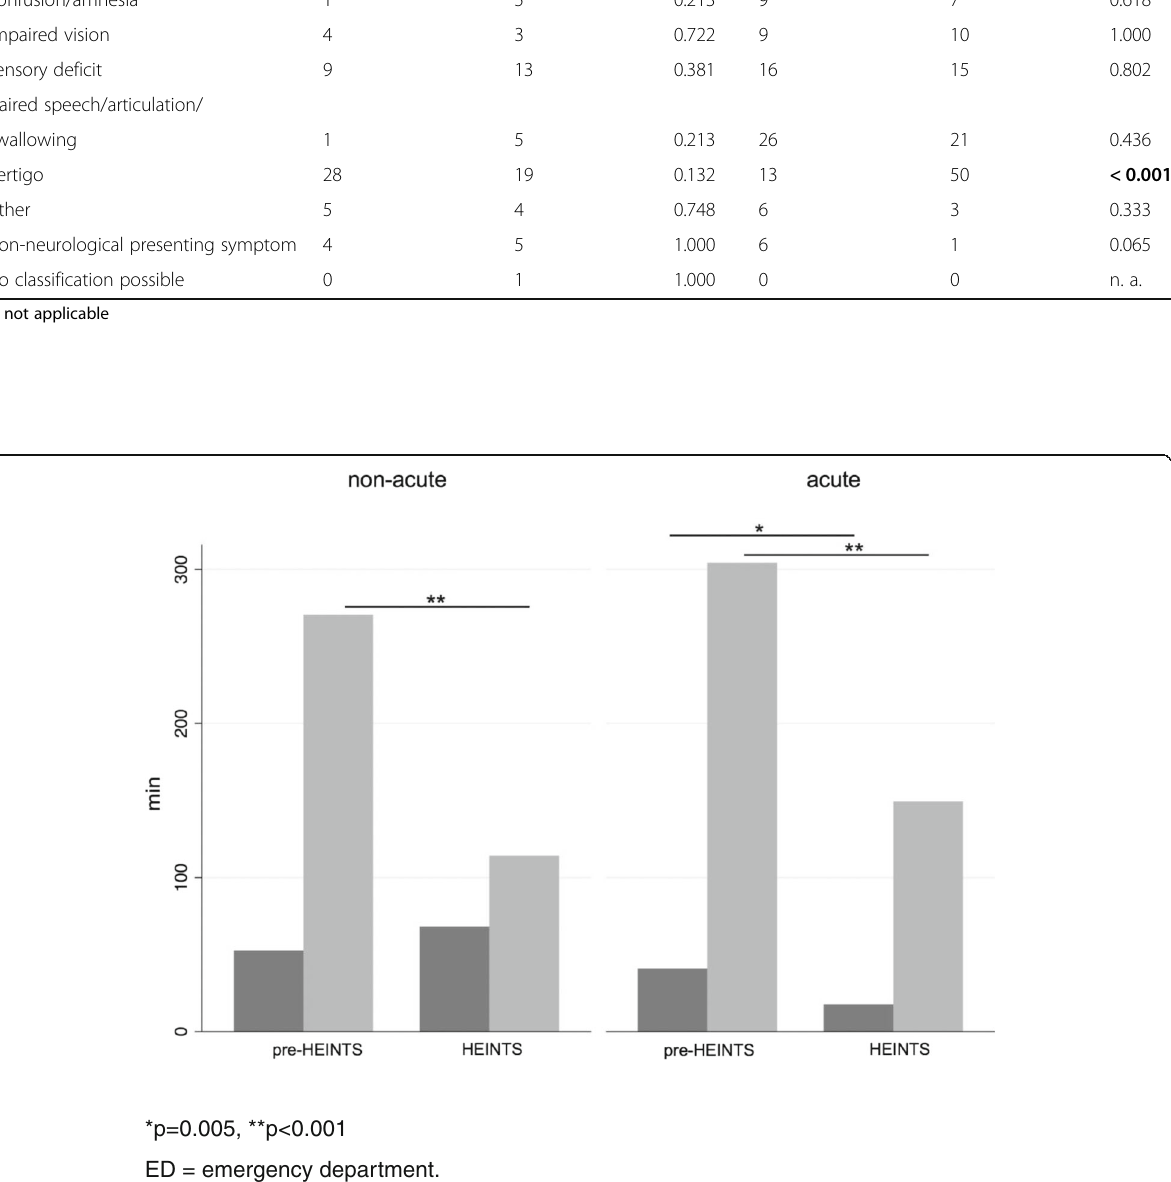
Fig. 3 Door-to-doctor time (dark grey) and ED length of stay (light grey) in the emergency department of pre-HEINTS and HEINTS patients with respect to acuity. * p = 0.005, ** p < 0.001 ED = emergency